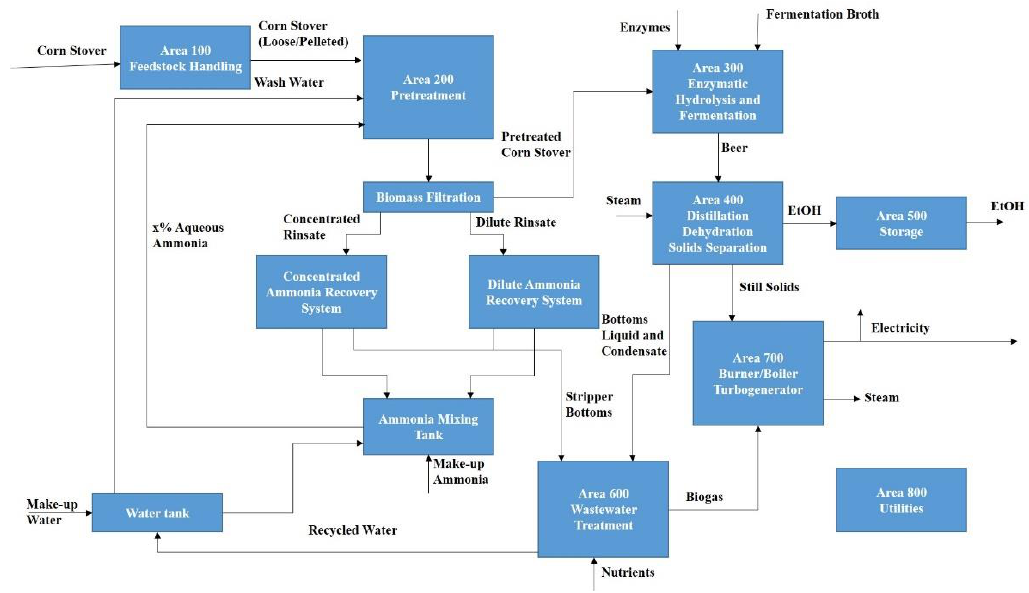
Figure 1. General process layout for cellulosic ethanol production from corn stover in a biorefinery.